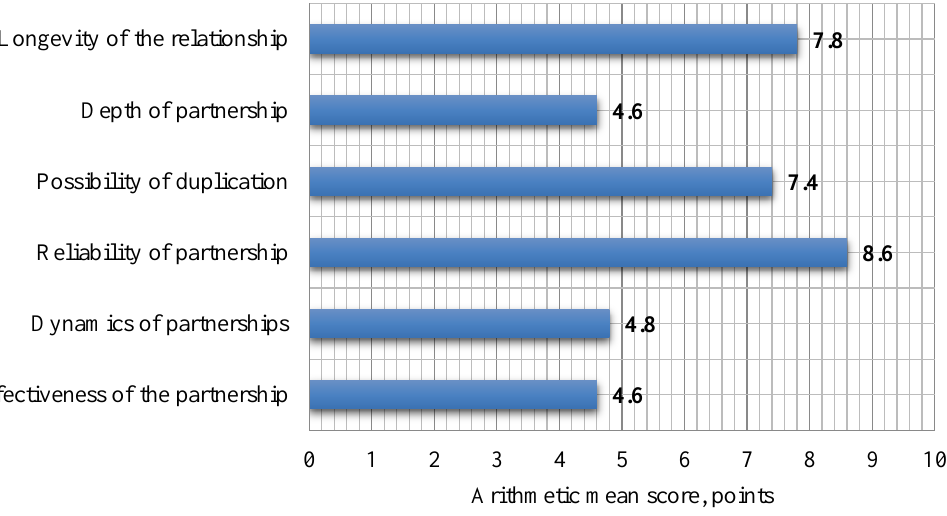
Fig. 2. Assessment of the importance of SPM partnership criteria according to the expert